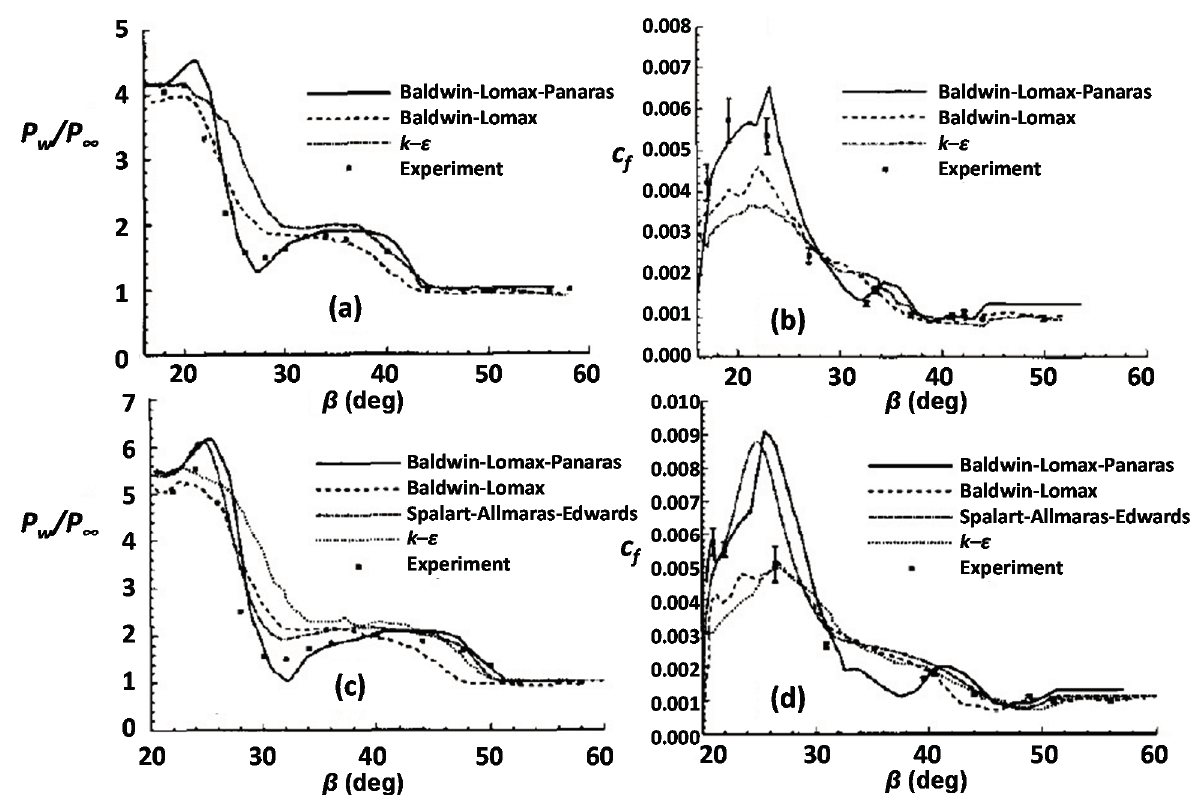
Figure 4. Wall pressure and skin friction variation: ( a , b ) SF4 test case and ( c , d ) SF6 test case